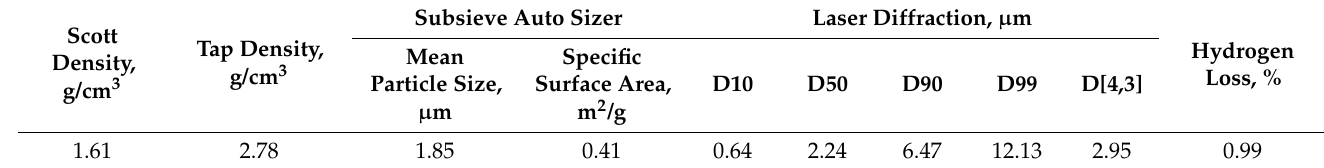
Table 2. Powder properties.